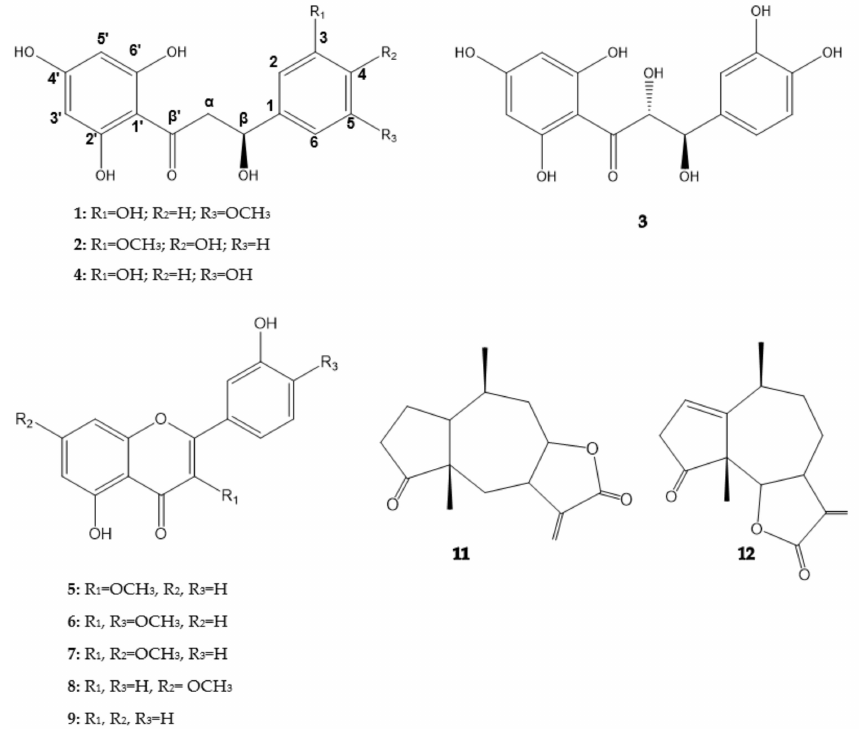
Figure 1. Chemical structures of purified metabolites from ethyl acetate extract from Ambrosia salsola : Salsolol A ( 1 ), salsolol B ( 2 ), salsolol C ( 3 ), balanochalcone ( 4 ), quercetin 3-methylether ( 5 ), quercetin 3,4 (cid:48) -methylether ( 6 ), quercetin 3,7-dimethylether ( 7 ), quercetin 7-methylether ( 8 ), quercetin ( 9 ), quercetin 3,4 (cid:48) ,7-trimethylether ( 10 ), confertin ( 11 ), and neoambrosin ( 12 ). Compound 3 was purified as an amorphous brownish powder, [ α ] 25 D +10.0 (c 0.1,